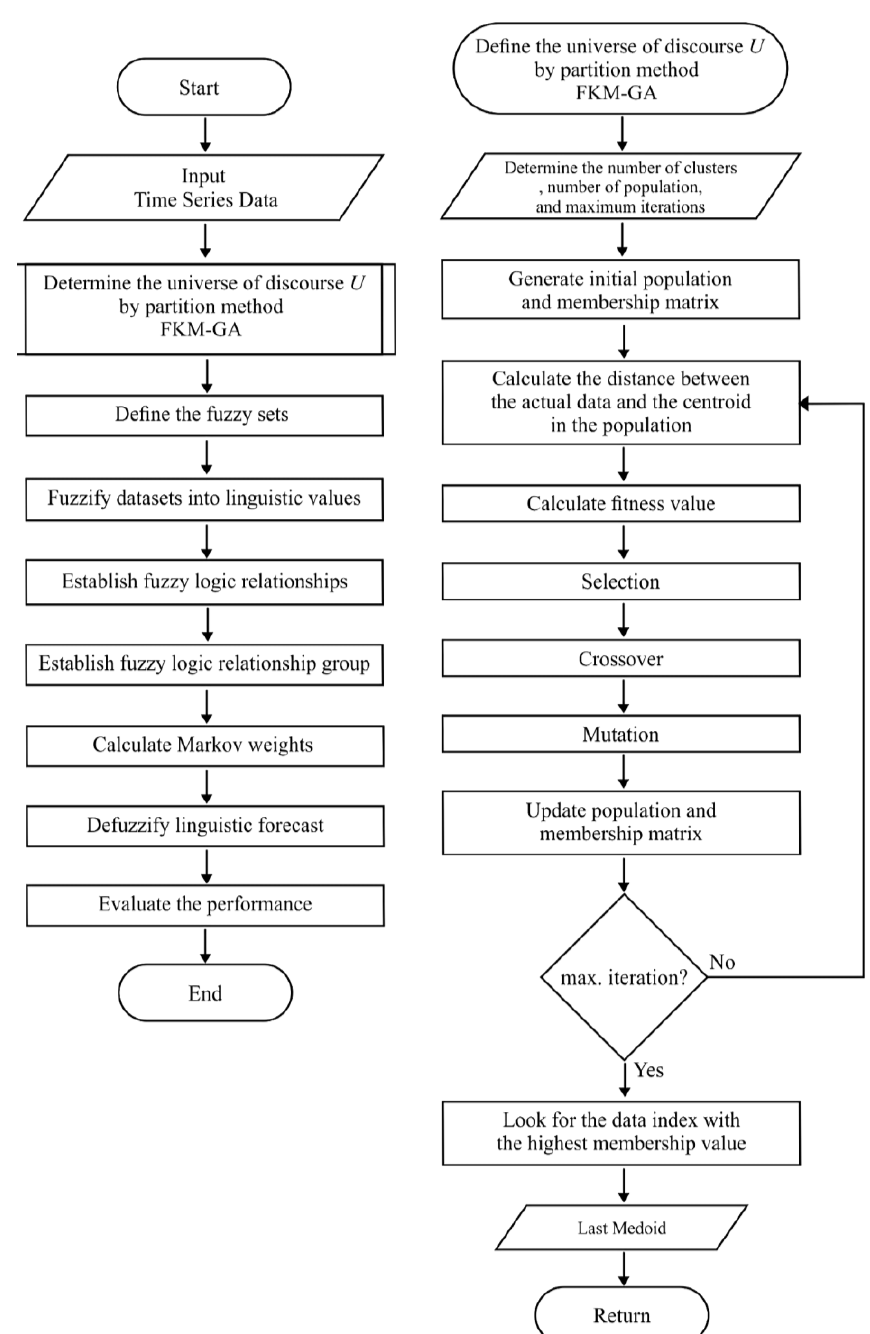
Figure 2. Flowchart